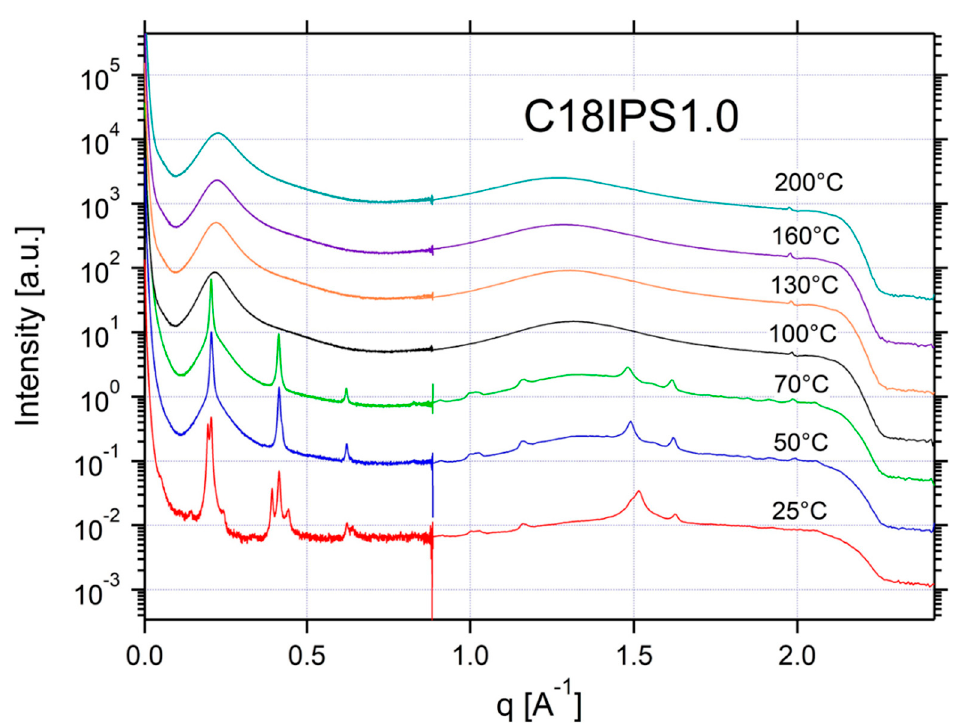
Figure A26. SAXS and WAXS data for 1:1 C18IPS:C18LiTFSI.